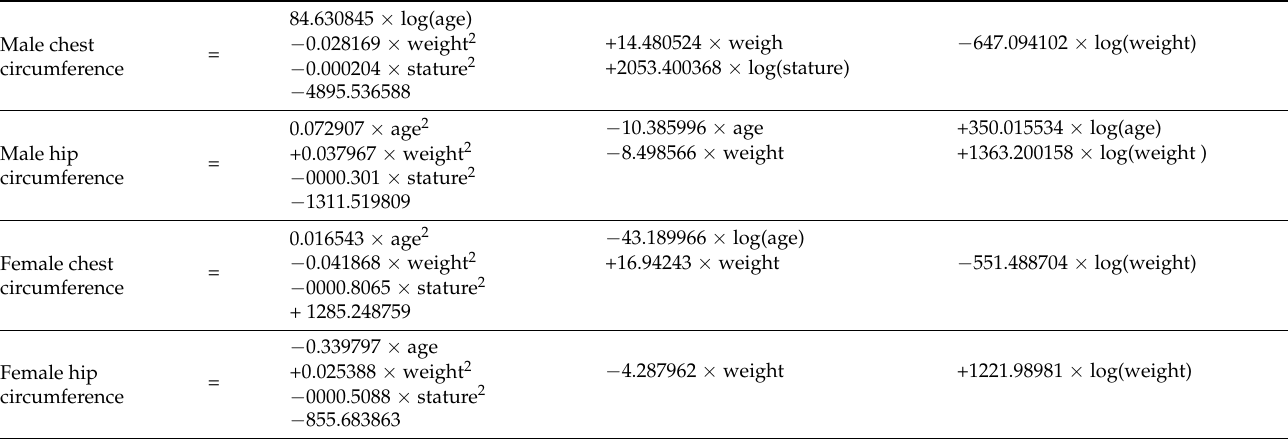
Table 1. Non-linear regression formulae to predict chest and hip circumferences for male and female